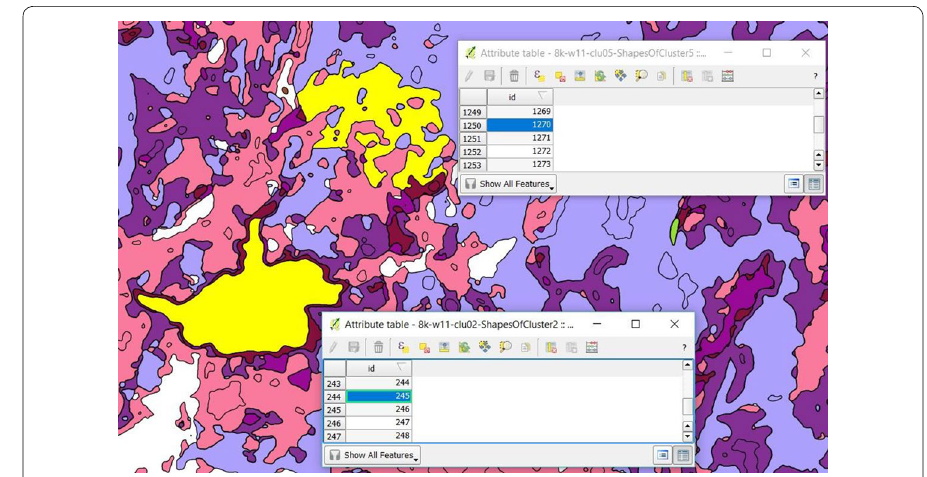
Fig. 21 Topological relationship for Case